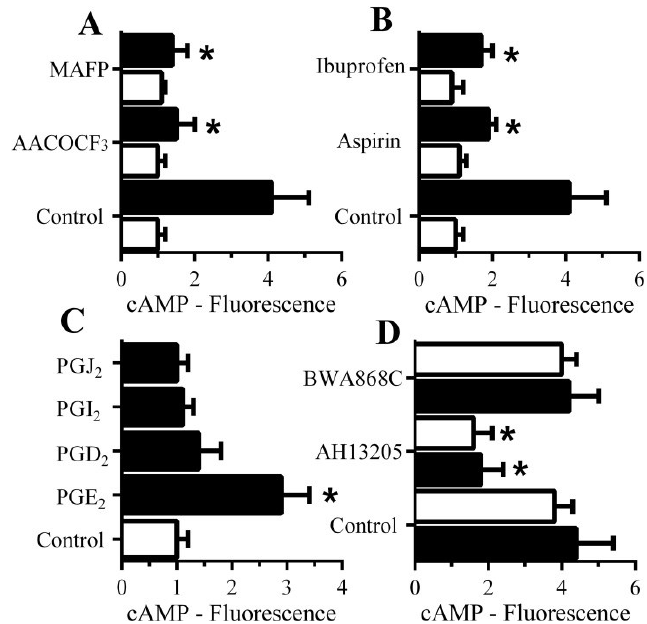
Figure 7. The Aβ-induced increase in synaptic cAMP is caused by PGE 2 : ( A ) The amounts of cAMP in synaptosomes pre-treated with control medium, 1 μM AACOCF 3 or 1 μM MAFP and incubated with control medium (□) or 1 nM Aβ 42 (■). Values are means ± SD, from triplicate experiments performed twice ( n = 6). * = cAMP significantly lower than synaptosomes incubated with Aβ; ( B ) The amounts of cAMP in synaptosomes pre-treated with control medium, 1 μM aspirin or 1 μM Ibuprofen and incubated with control medium (□) or 1 nM Aβ 42 (■). Values are means ± SD, from triplicate experiments performed twice ( n = 6). * = cAMP lower than synaptosomes incubated with Aβ; ( C ) The amounts of cAMP in synaptosomes incubated with control medium (□) or 1 nM prostaglandins as shown (■). Values are means ± SD, from triplicate experiments performed twice ( n = 6). * = cAMP significantly higher than control synaptosomes; ( D ) The amounts of cAMP in synaptosomes pre-treated with control medium, 100 nM AH13205 (a prostanoid E receptor antagonist) or 100 nM BWA868C (a prostanoid D receptor antagonist) and incubated with 1 nM Aβ 42 (■) or 100 nM αSN (□). Values are means ± SD, from triplicate experiments performed twice ( n =